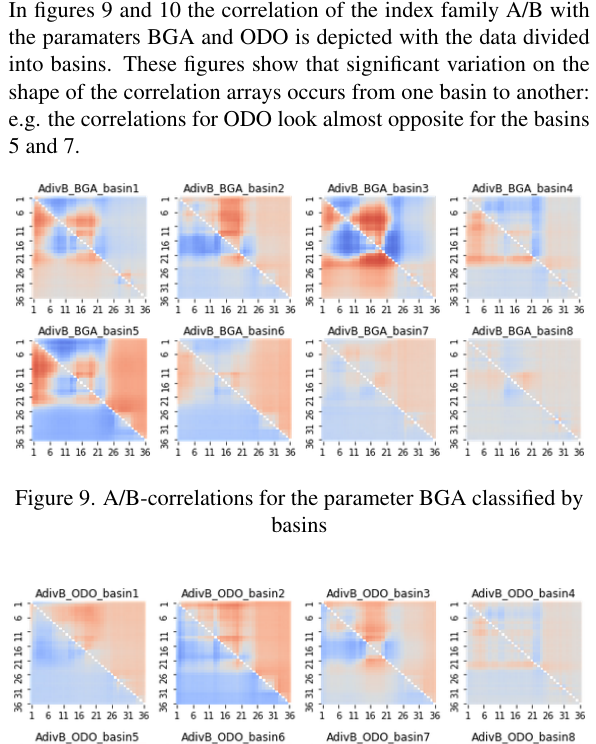
Figure 8. A/B-correlations for the parameters BGA and ODO in the whole data